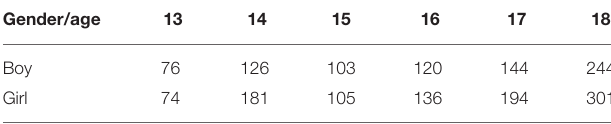
TABLE 1 | Distribution of sample gender and